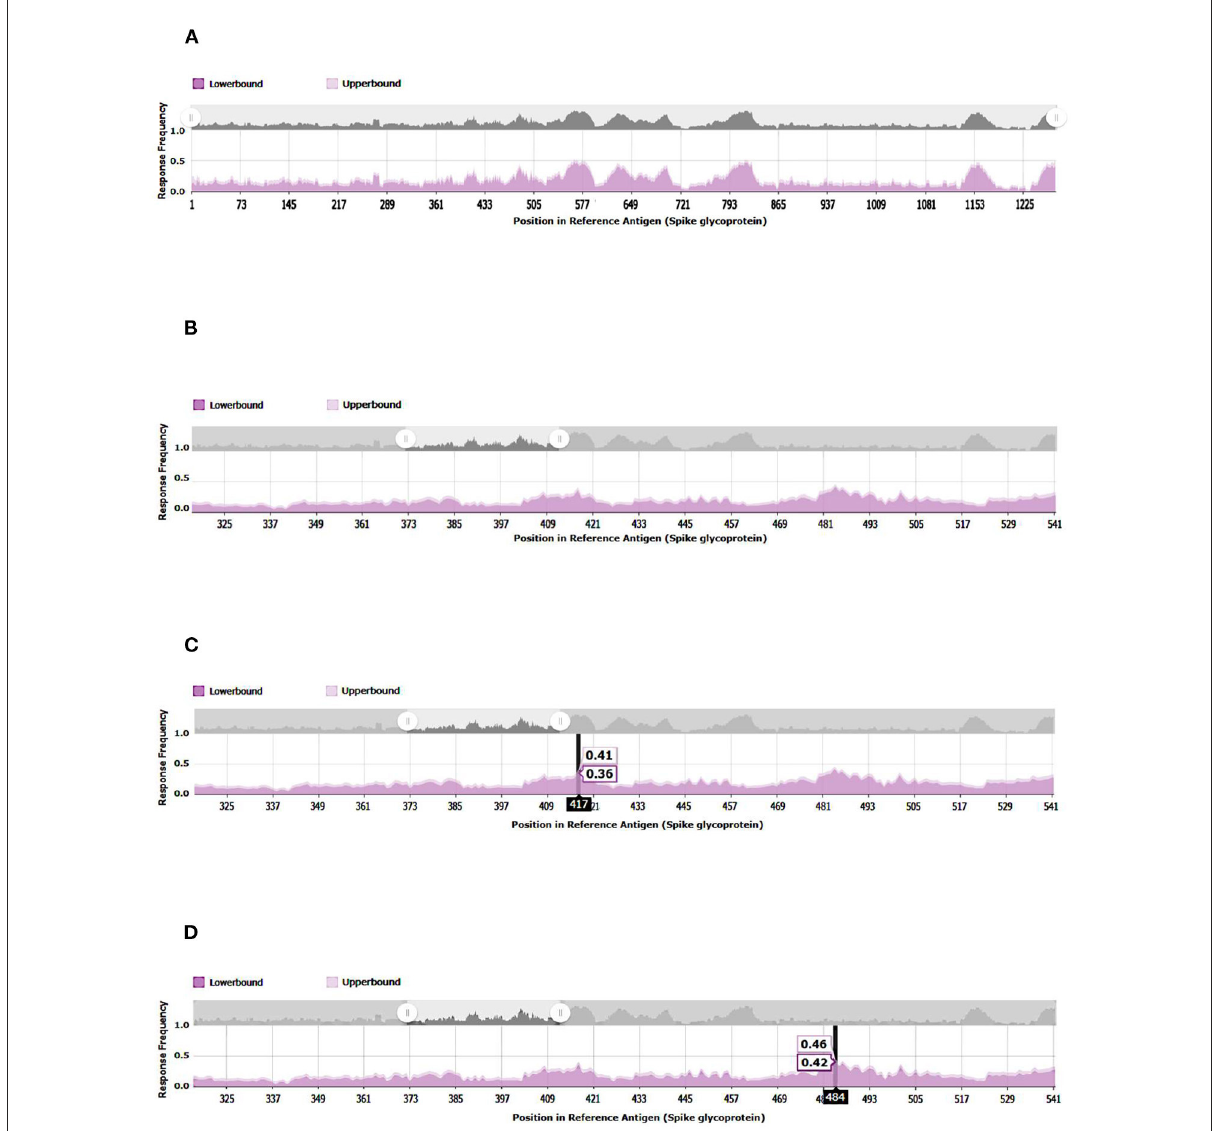
FIGURE5 Immunome Browser maps, which shows the linear peptide epitopes filtered in the Immune Epitope Database along the SARS-CoV-2 glycoprotein spike sequence studied in immunoassays. (A) SARS-CoV2-S, spike glycoprotein (UniProt: P0DTC2). (B) SARS-CoV- 221 2-S-RBD, receptor-binding domain (UniProt: P0DTC2 amino acids 317 to 533). (C) Relevant amino acid of SARS-CoV-2-S-RBD involved in immune evasion. (D) Relevant amino acid of SARS-CoV-2-S-RBD involved in immune